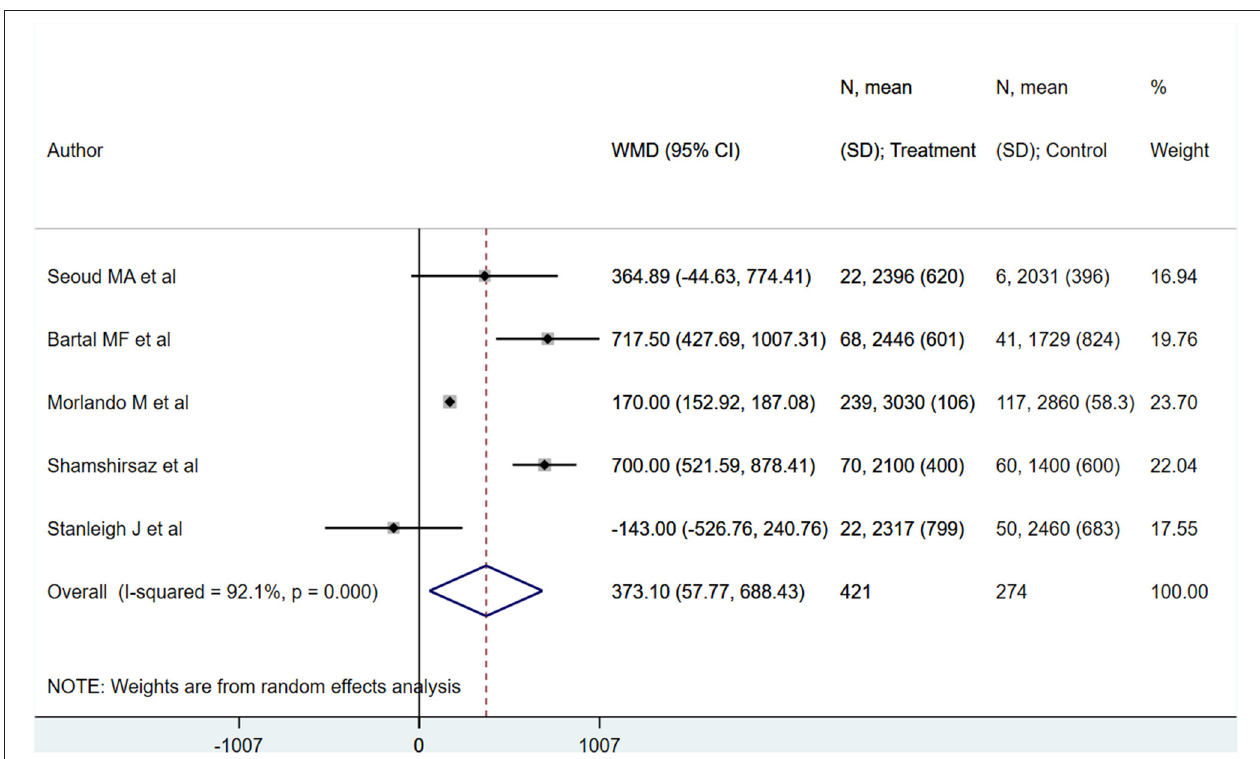
FIGURE 7 | Neonatal weight for babies born to PAS patients via planned or emergency